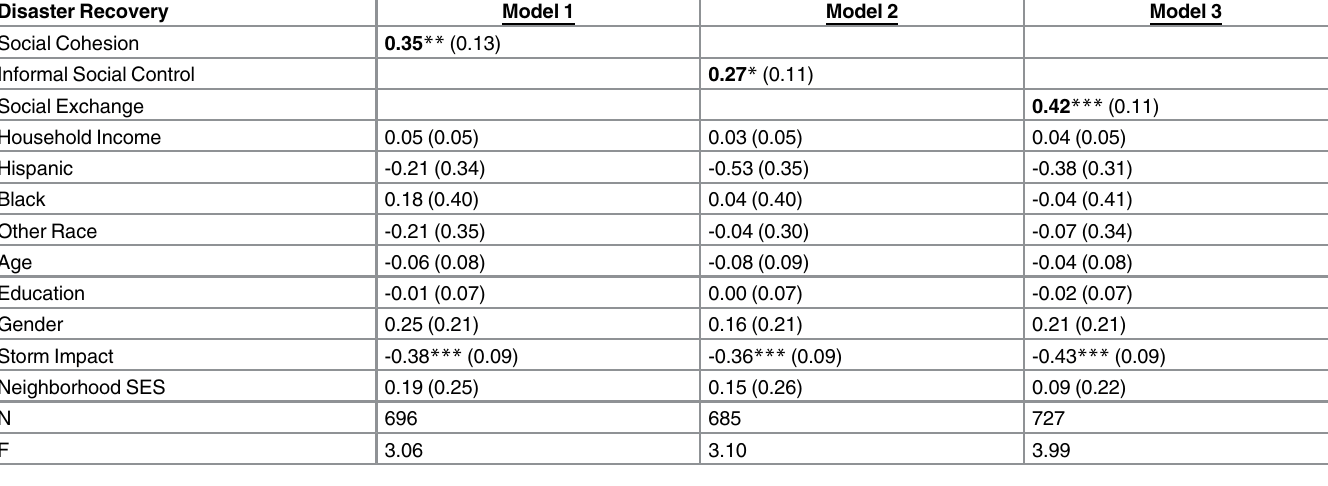
Table 3. Social cohesion, social control and social exchange and their associations with beliefs about recovery from future